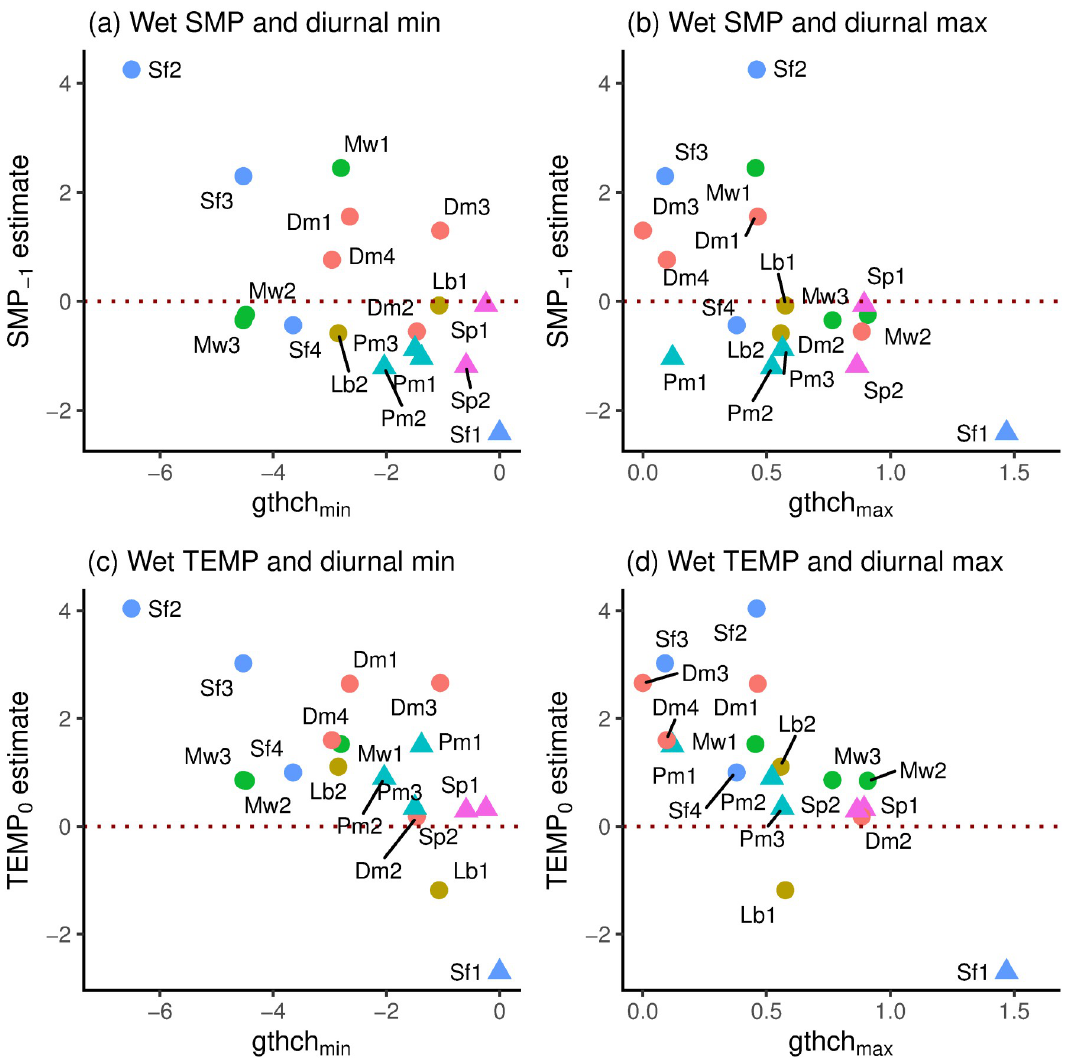
Fig 9. Standardized SMP and TEMP 0 coefficients in the wet period in relation to diurnal girth change ( gthch ). In (a, c) the − 1 minima, and in (b, d) the maxima, of gthch are used ( n = 18). Symbols as in Fig 6.